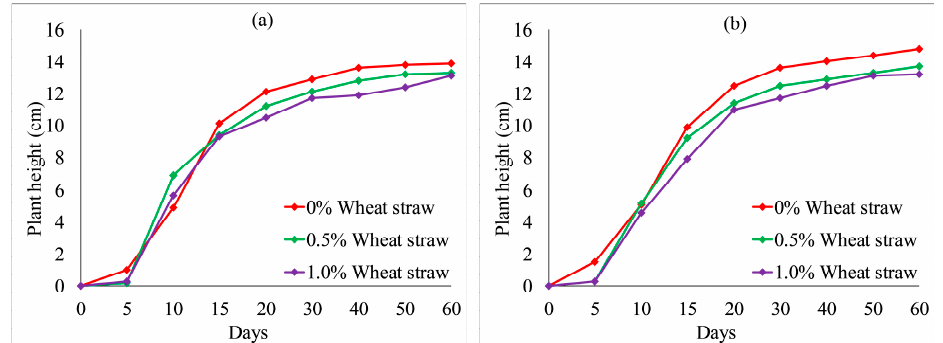
Figure 13. Festuca elata height relative to fly ash content combined with: ( a ) 5% KW fertilizer con- tent; ( b ) 10% KW fertilizer content.